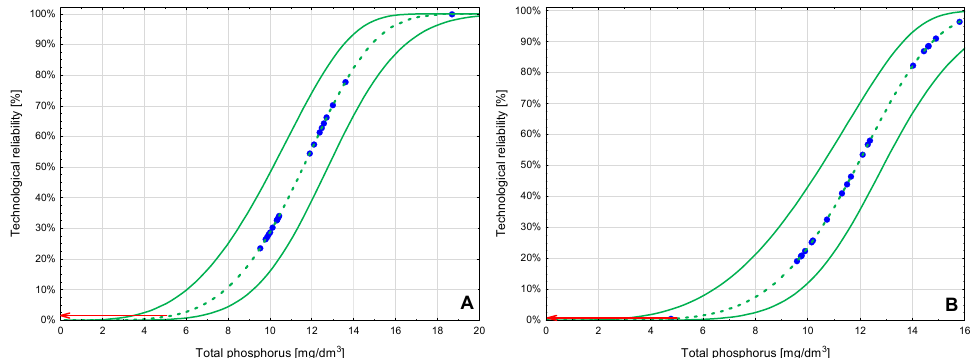
Figure 6. Weibull cumulative distribution functions and the technological reliabilities determined for TN (( A )—facility no. 1; ( B )—facility no. 2). Notation : dashed green line—reliability function, continuous green line—confidence intervals, red arrows—probability of achieving the indicators limit in the effluent.